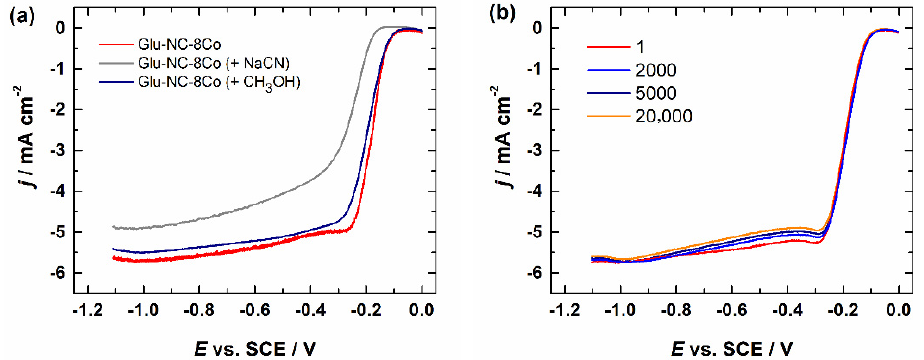
Figure 6. RDE voltammetry curves for O 2 reduction on Glu-NC-8Co catalyst in O 2 -saturated 0.1 M KOH ( a ) in the presence of 10 mM NaCN or 3 M methanol, ( b ) before and after a certain number of potential cycles between 0 and − 0.4 V. ω = 1900 rpm, ν = 10 mV s − 1 .